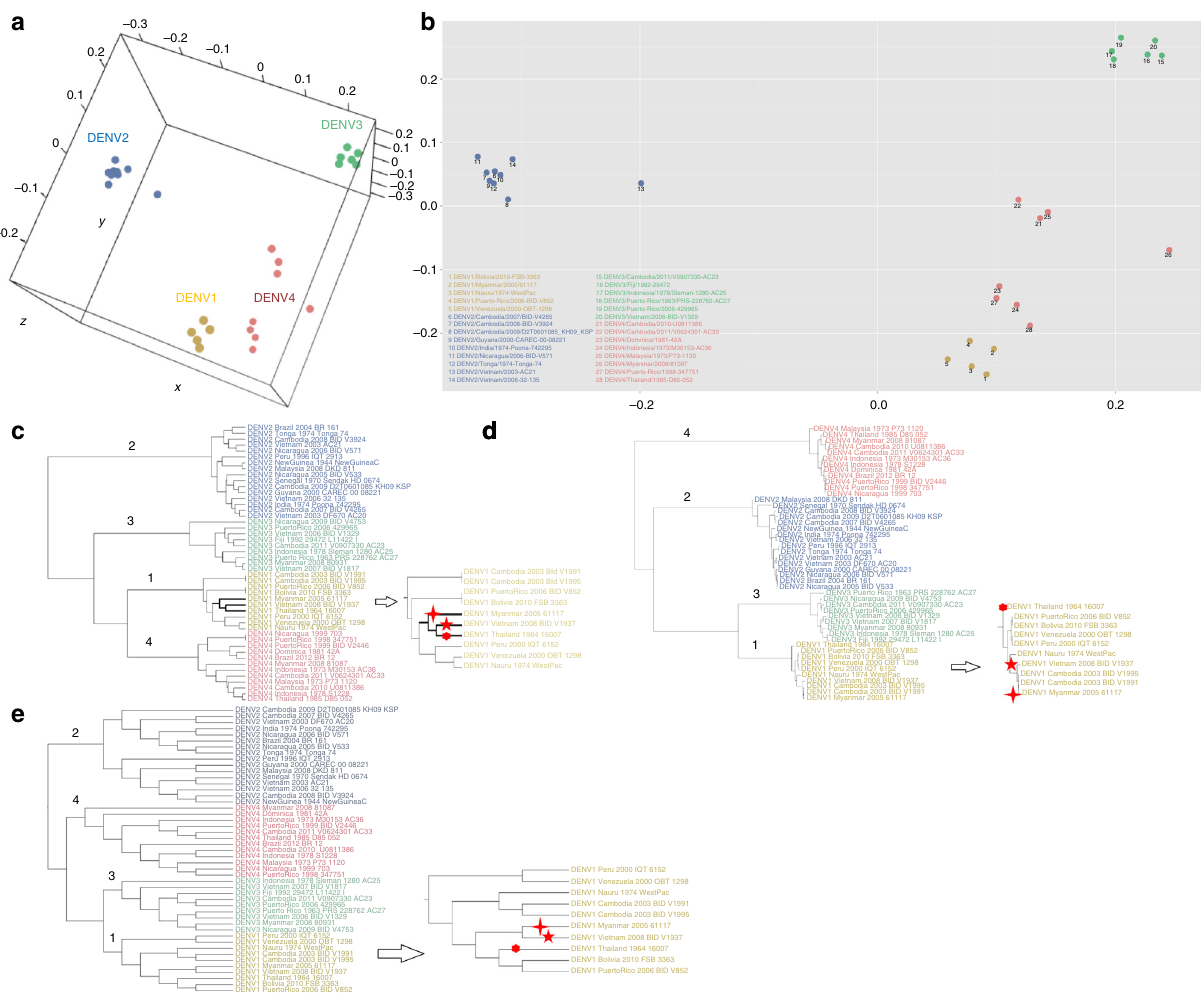
Fig. 4 Subtype grouping of dengue virus by CE-BLAST. a 3D antigenic mapping of 28 dengue virus strains based on the serological data from Katzelnick et al. 6 by MDS. b 2D antigenic mapping of Fig. 4a. c Antigenic clustering of 47 strains by CE-BLAST similarity score. d Traditional grouping by sequence phylogenetic tree of 47 E protein sequences. e Traditional grouping by structural clustering tree of 47 E proteins based on RMSD scores of the Multiprot 19 . Strains DENV1/Vietnam/2008-BID-V1937, DENV1/Thailand/1964/16007, and DENV1/Myanmar/2005/61117 were marked with star, dot, and